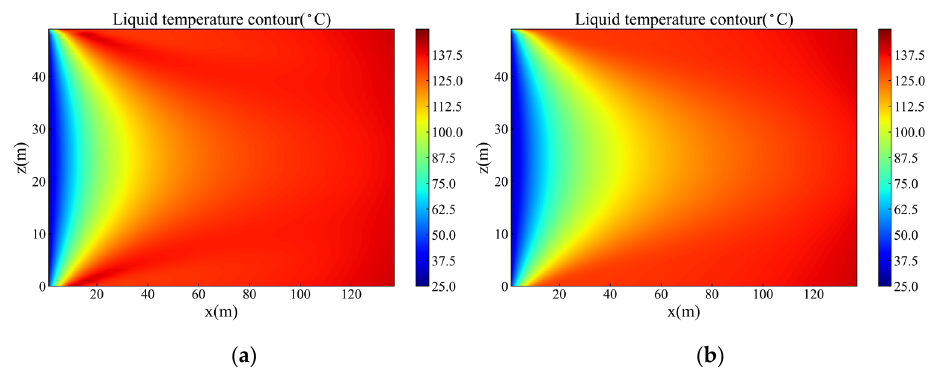
Figure 5. Thermal map of fluid temperature distribution in the fracture leak-off zone with and with- out considering acid–rock reaction heat. ( a ) considering reaction heat, ( b ) without considering reac- tion heat.